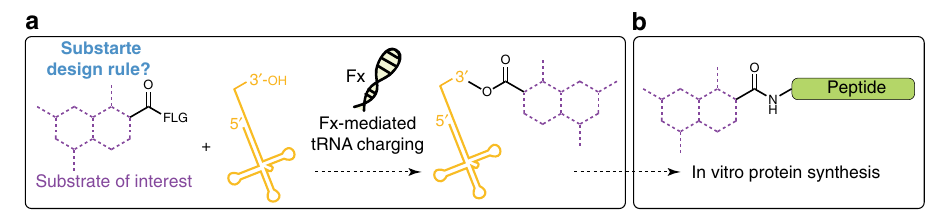
Fig. 1 Expanding the chemical substrate scope of fl exizymes for genetic code reprogramming. a Flexizyme (Fx) recognizes the 3 ’ -CCA sequence of tRNAs 64 and catalyzes the acylation of tRNA using acid substrates. We seek to develop substrate design rules for fl exizyme-mediated acylation reactions that expand the scope of chemical substrates used in ribosome-directed polymerization. b An Escherichia coli cell-free protein synthesis system reconstituted from the puri fi ed wild-type translational machinery (PURExpress) is used to produce peptide 25,65 containing noncanonical acid substrates. This approach for incorporating noncanonical monomers at the N-terminus of peptides is well established. Flexizyme-Leaving Group (FLG) alternatives include CME, DNBE,